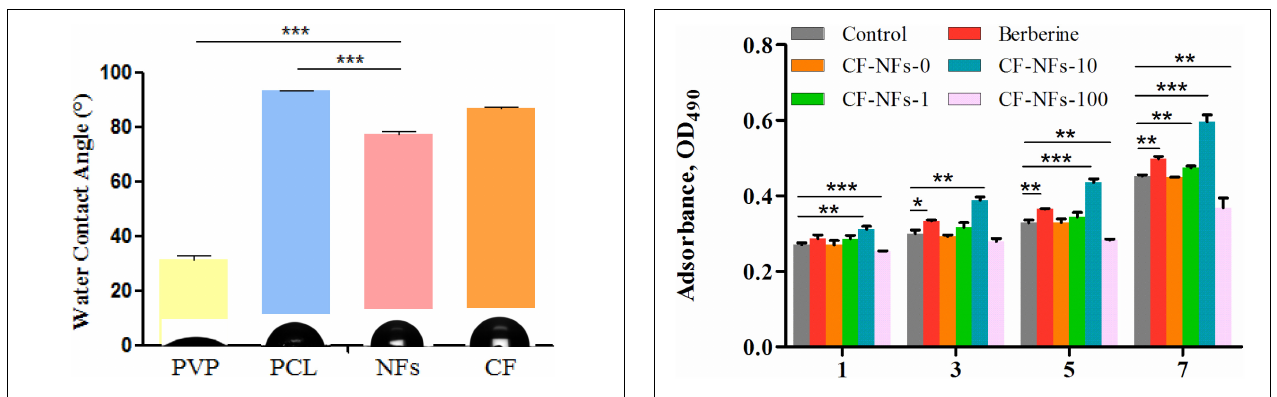
FIGURE 6 | Evaluation of cell proliferation with the MTT on day 1, 3, 5, and 7 of culture. * P < 0.05, ** P < 0.01, *** P <